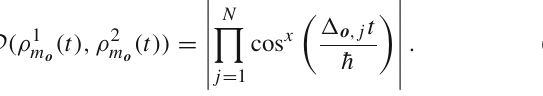
environment particles n x . a (cid:2) – c (cid:2) The QSLT for the dynamics process of the system particle m o from the initial state ρ s ( 0 ) = 1 |